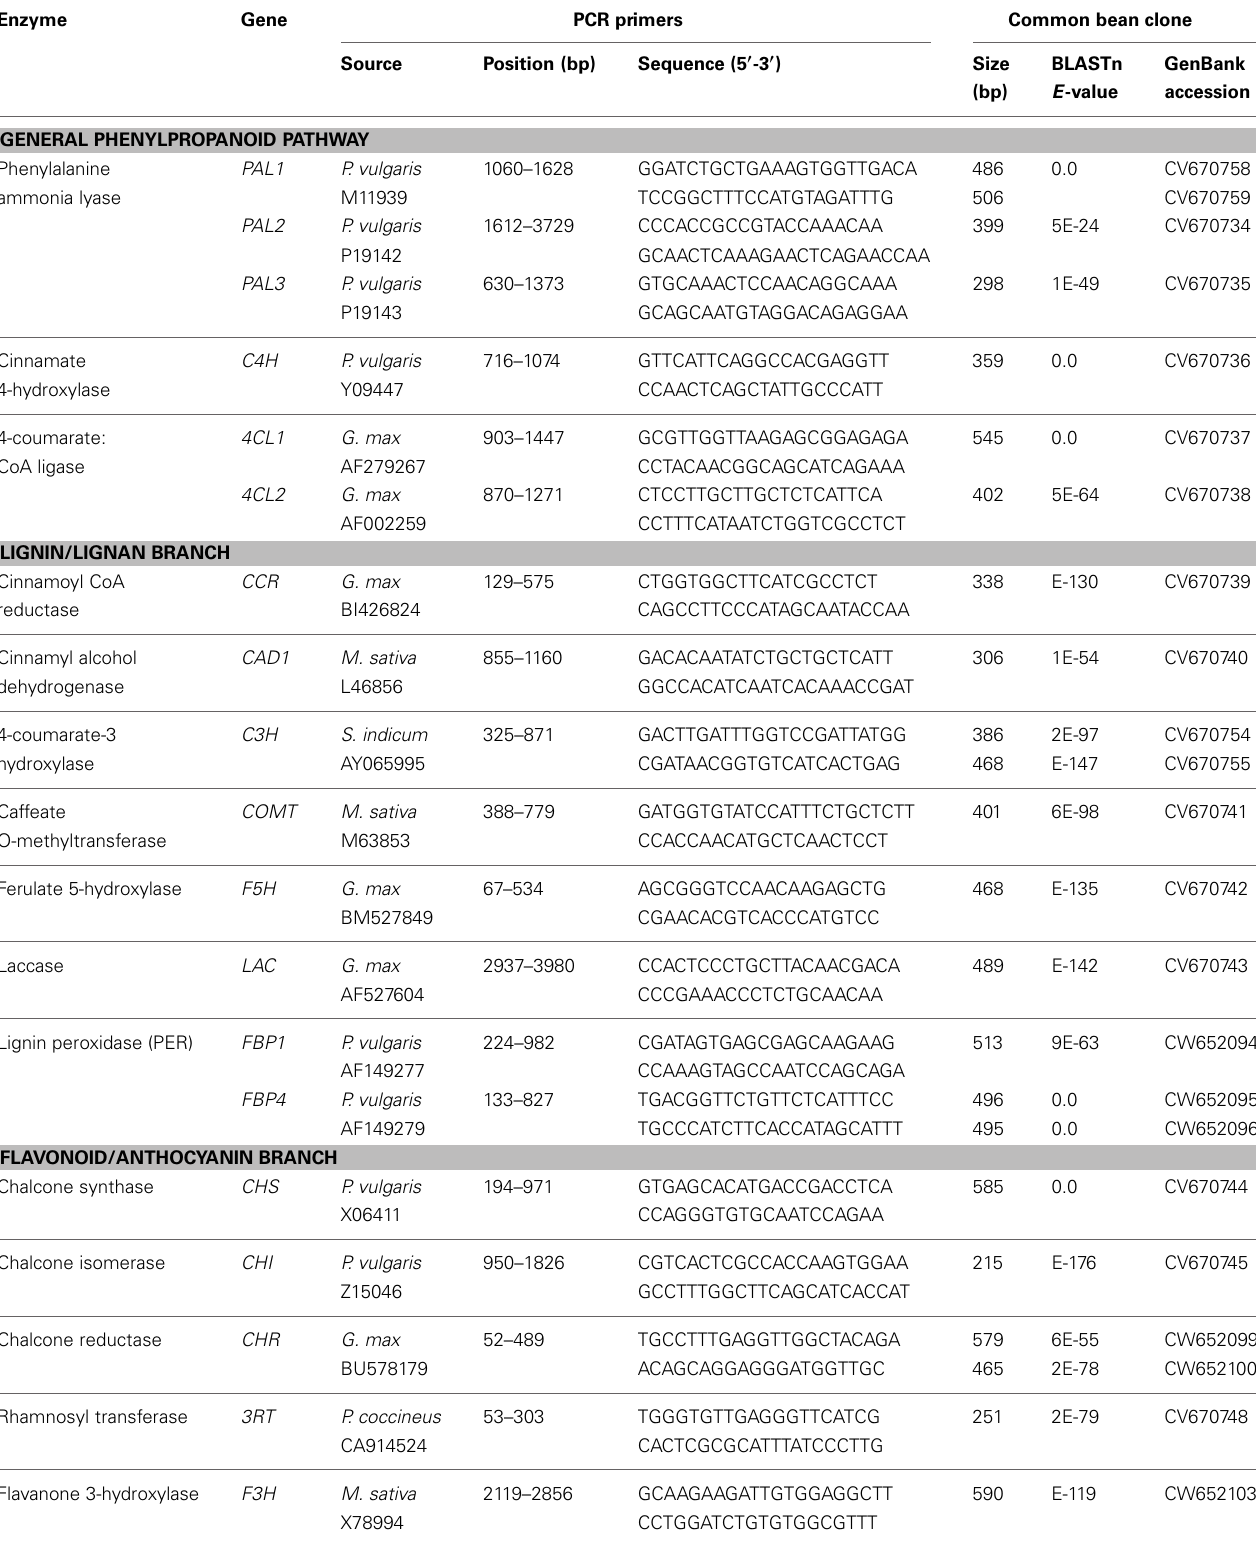
Table 2 | Cloned phenylpropanoid pathway gene fragments in common